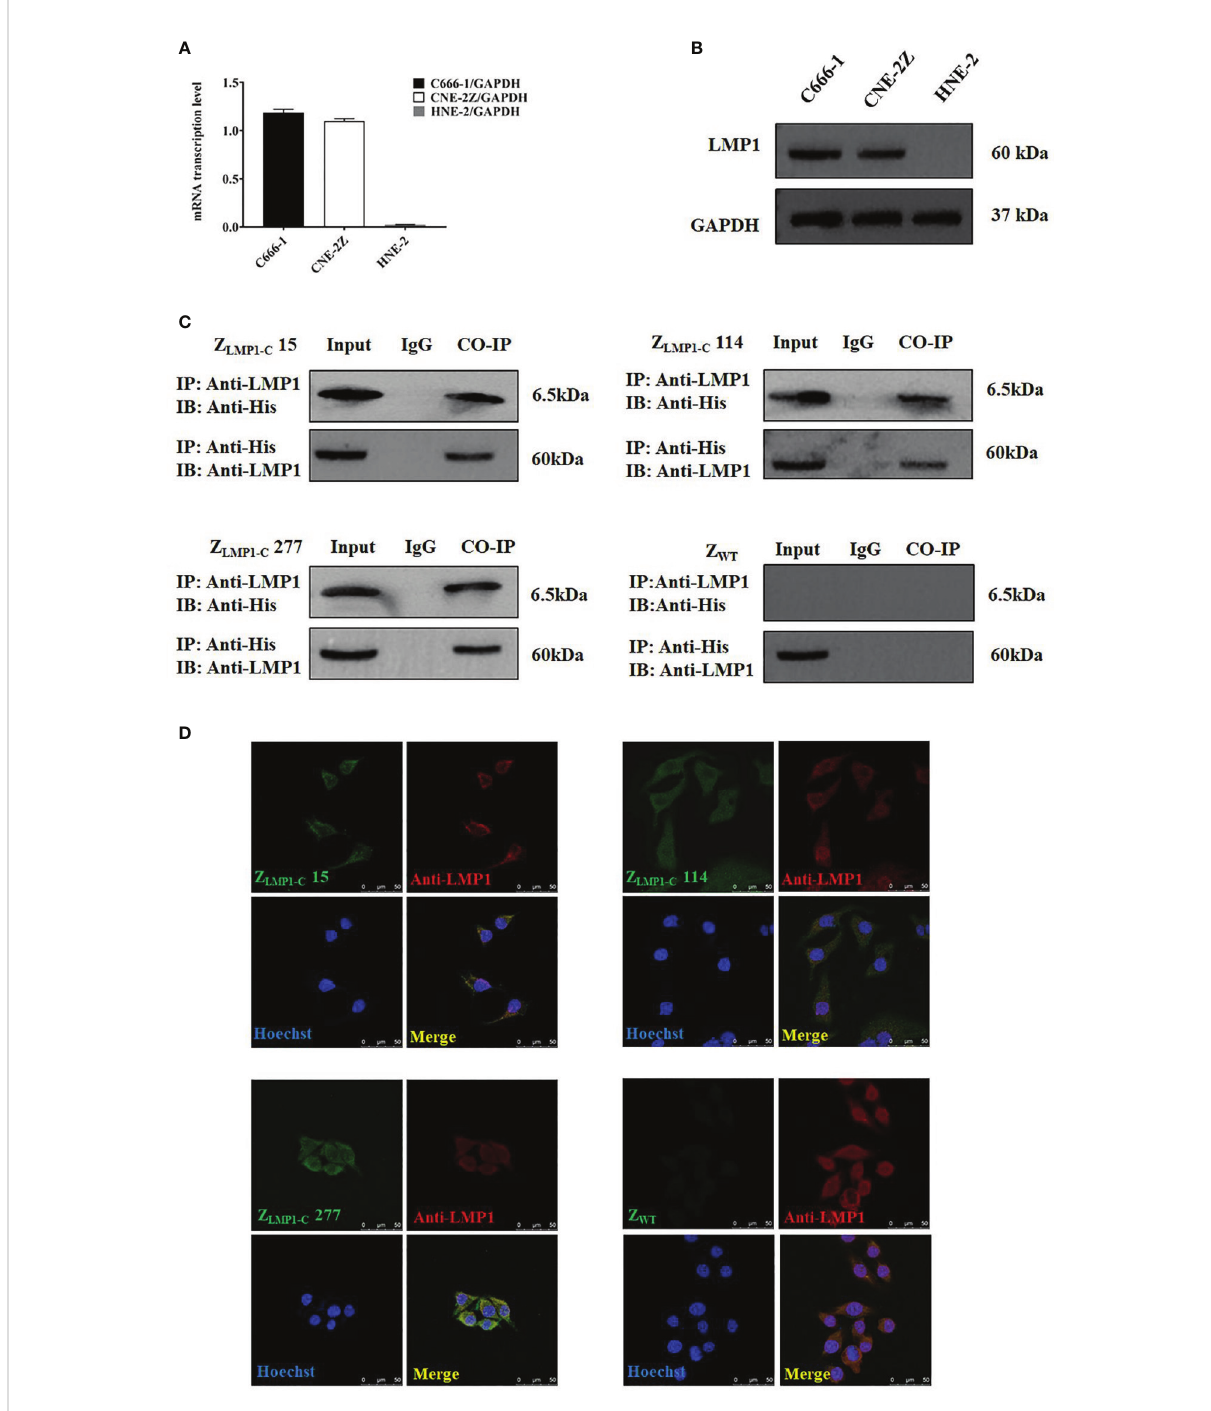
FIGURE 2 Analysis of intracellular protein. (A) RT-PCR analysis of LMP1/GADPH in C666-1, CNE-2Z and HNE-2. (B) LMP1expression level in C666-1, CNE- 2Z and HNE-2 cells by Western blotting assay. Data are given as mean ± SD (n=3). (C) Z LMP1-C af fi body molecules complexed with LMP1, then an IP was performed with an anti-LMP1 antibody. Western blotting was performed and incubated with rabbit anti-LMP1 mAb or mouse anti-His- tag mAb. IgG served as a negative control. (D) . EBV-positive NPC cell lines (C666-1) were treated with Z LMP1-C or Z WT af fi body molecule for 3 h and images were collected by confocal microscopy. Rabbit anti-LMP1 mAb recognized LMP1 and anti-His-tag-mouse mAb are the primary antibodies that were used. Goat anti-rabbit IgG antibody, Cy3 (red) conjugate and goat anti-mouse IgG antibody, FITC Conjugated (green) were used as secondary antibodies. Blue are cell nuclei stained with Hoechst 3342 and yellow are the merge images that showed the co-localization between Z LMP1-C af fi body molecules and anti-LMP1. Scale bar = 50 m